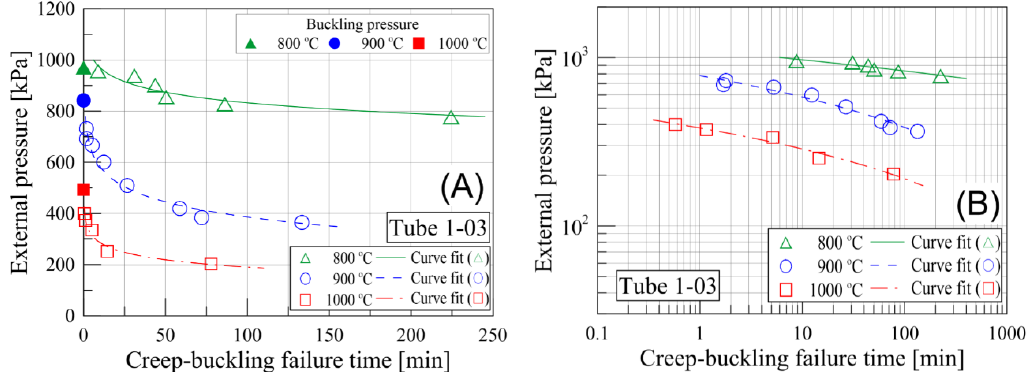
Figure 8. Measurements of the creep-buckling failure for Tube 1-03: ( A ) linear horizontal axis and ( B ) logarithmic horizontal axis.